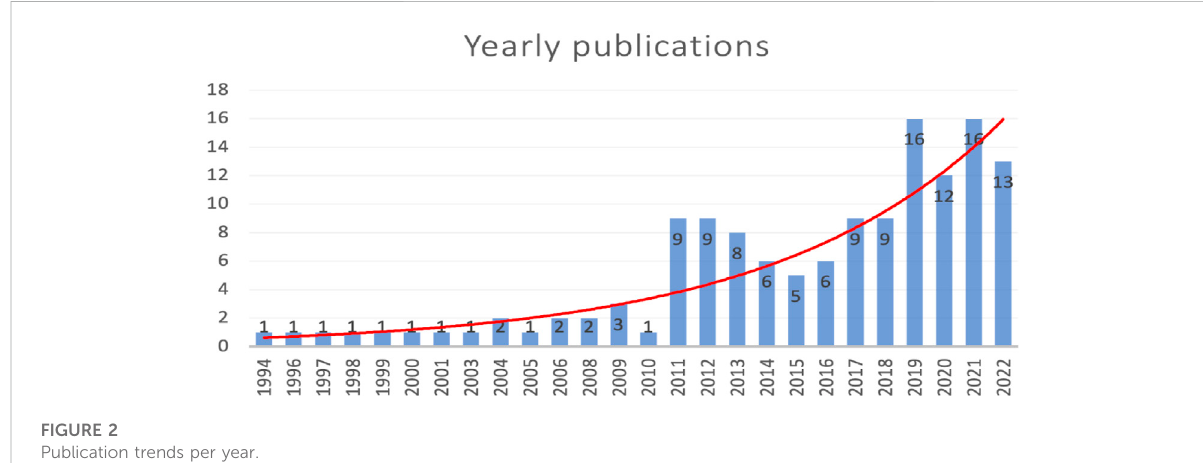
FIGURE 2 Publication trends per